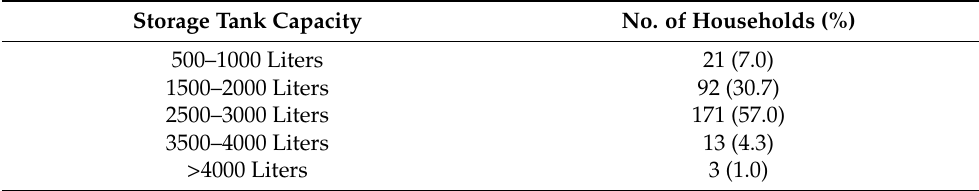
Table 3. Current storage capacity for rainwater collection in coastal